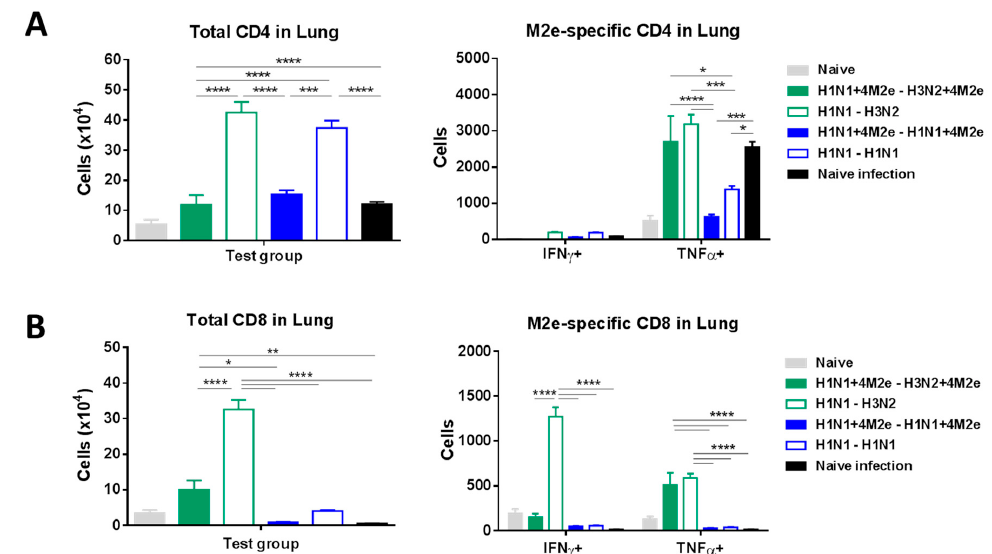
Figure 10. CD4 ( A ) and CD8 ( B ) T-cell responses in the lungs of LAIV-vaccinated mice and naïve mice